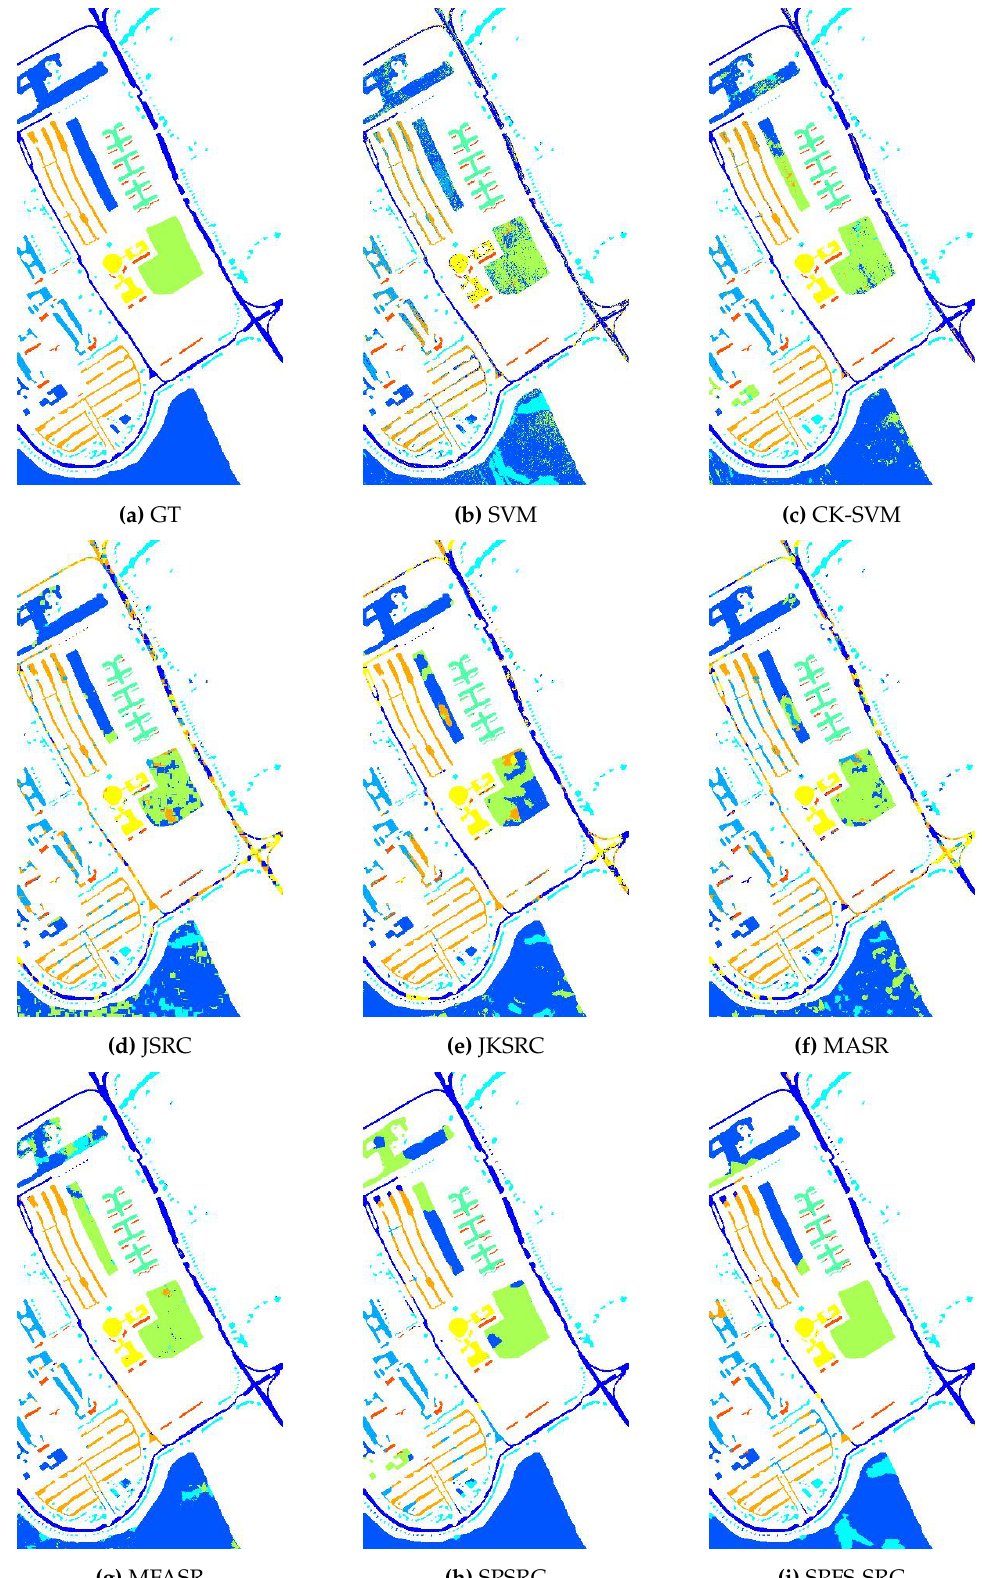
Figure 6. The classification map of the PaviaU dataset. ( a ) the Ground Truth (GT), ( b ) SVM, ( c )